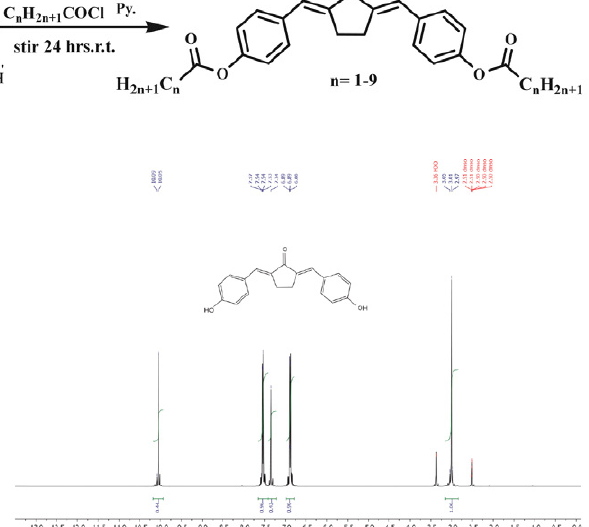
Figure 3: 1 H NMR spectrum for chalcone